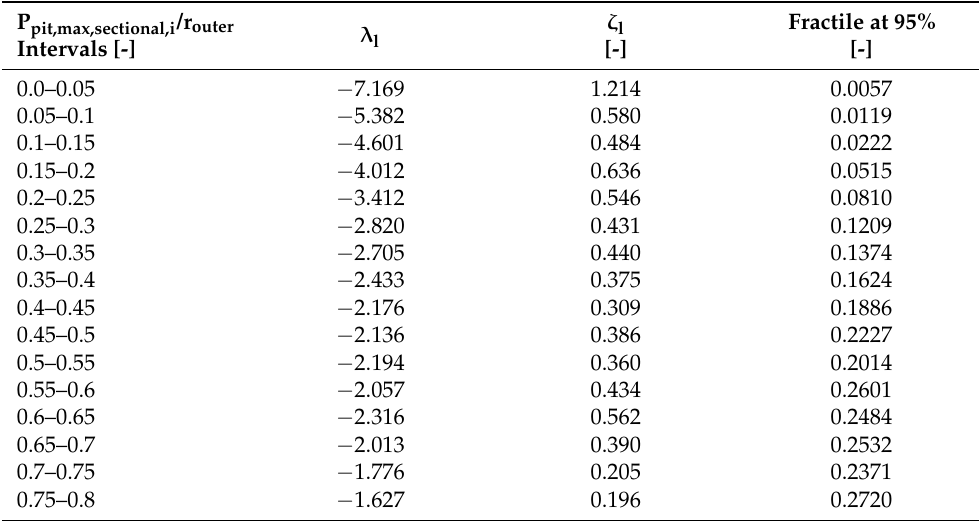
Table 3. Key features of lognormal distributions of Ω i